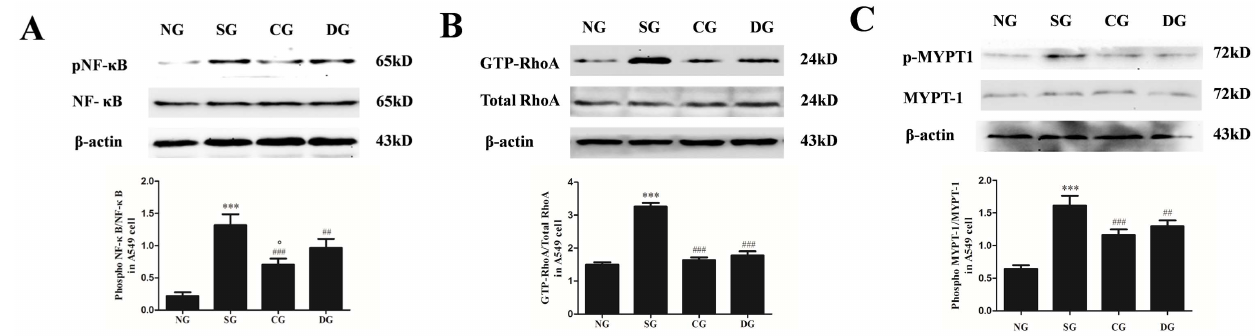
Figure 4. Effects of calcitriol on NF- k B p65 activation and RhoA/ROCK pathway in A549 cells. After 4 h seawater treatment, proteins were obtained for western blot. The ratios of pNF- k B versus NF- k B, GTP-RhoA versus total-RhoA and p-MYPT1 versus MYPT1 were obtained for each group to examine the pNF- k B, GTP-RhoA and p-MYPT1 content. NG: normal group; SG: seawater group; CG: 10 2 6 M calcitriol group; DG: dexamethasone group. n=6, ***P , 0.001 versus group NG, ## P , 0.01, ### P , 0.001 versus group SG, u P , 0.05 versus group DG.